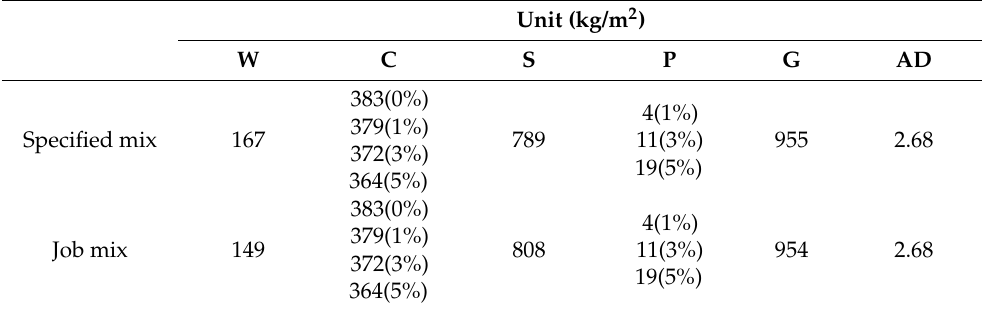
Table 6. Addition of ABS, PVDF powder (0%, 1%, 3%, 5%) in specified and job mix specimen (W: blended water, C: cement, S: fine aggregate, P: powder, G: coarse aggregate, AD: admixture).